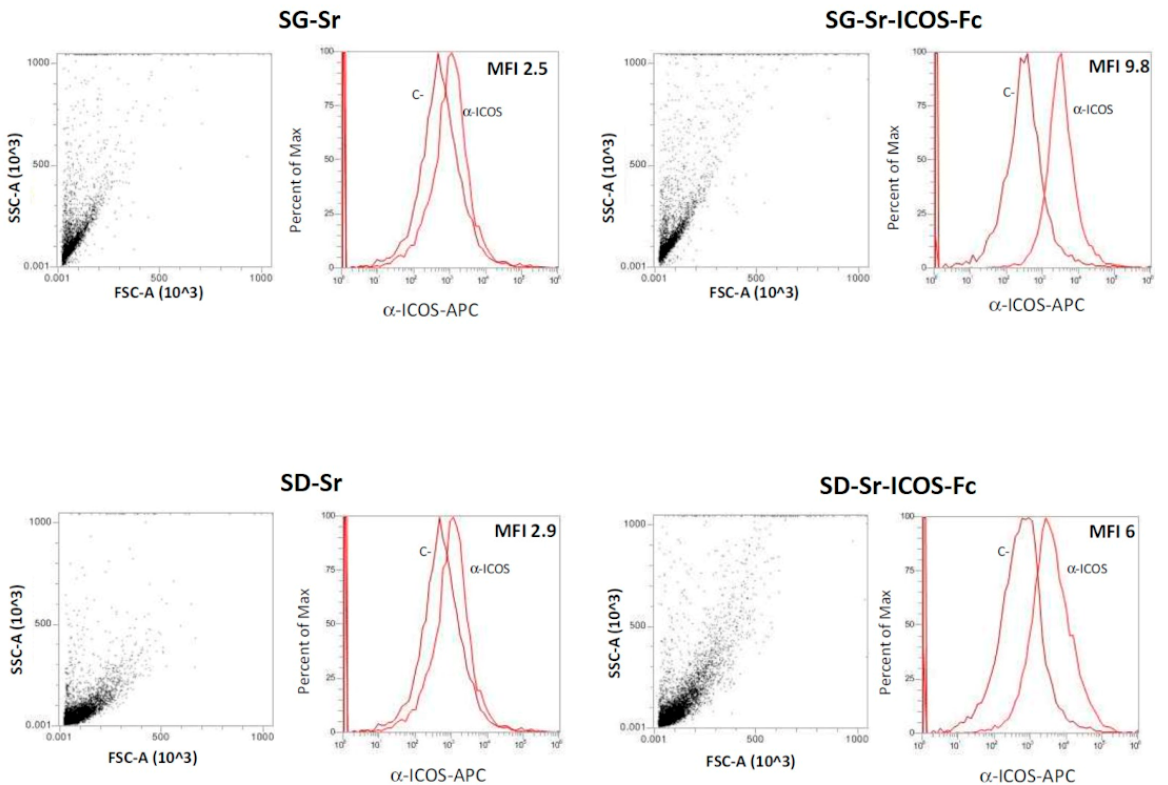
Figure 10. Cytofluorimetric analysis and MFI-R results for SG-Sr-ICOS-Fc, SD-Sr-ICOS-Fc, SG-Sr and SD-Sr. Dot plots and cytofluorimetric histograms of ICOS-Fc for each sample tested are shown. C-: unstained sample; α -ICOS: sample stained with the antibody. FSC: forward scatter; SSC: side scatter.